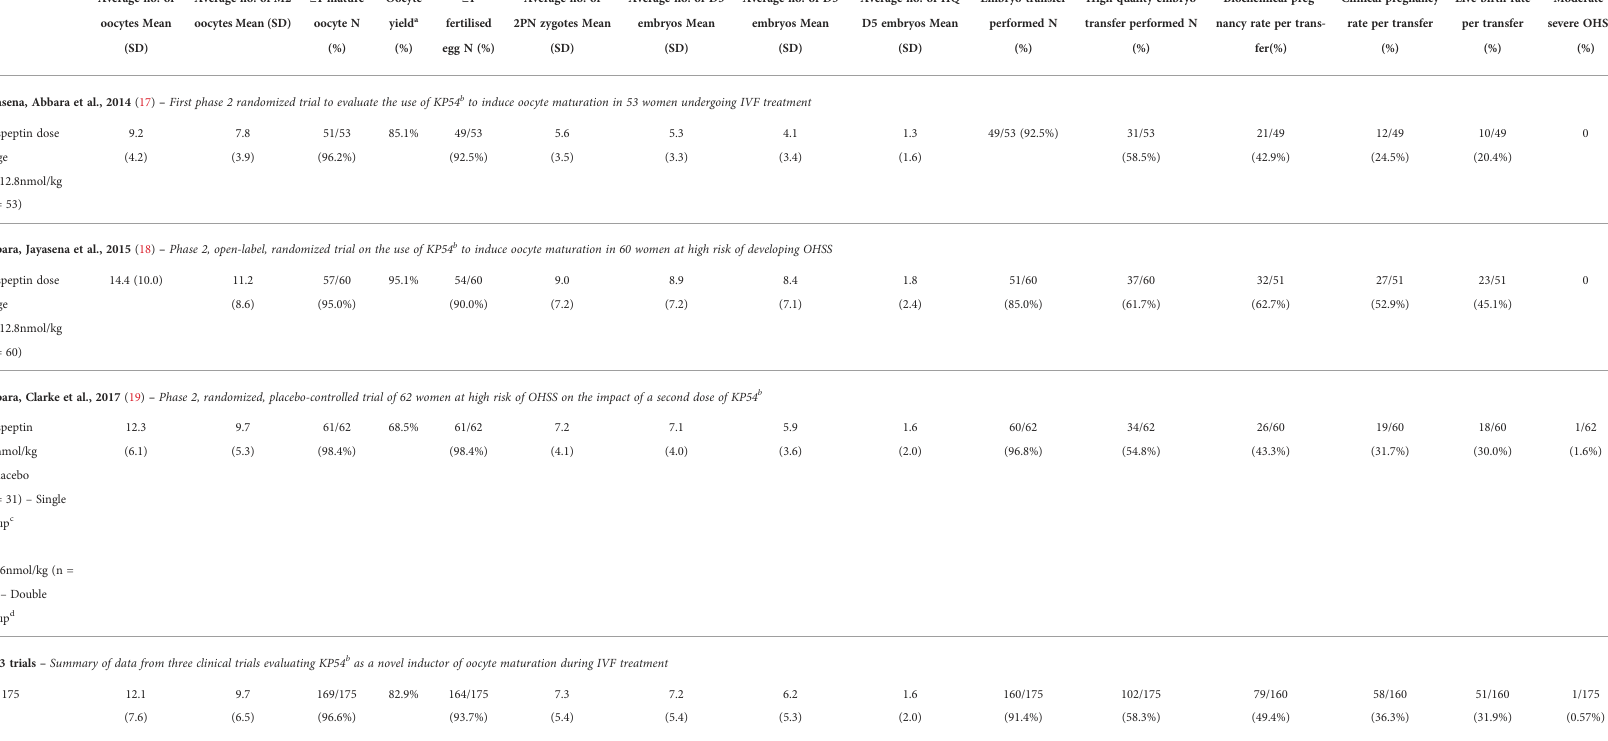
TABLE 1 Summary of data from three clinical trials evaluating KP54 c as a novel trigger of oocyte maturation in IVF treatment. Averageno. of